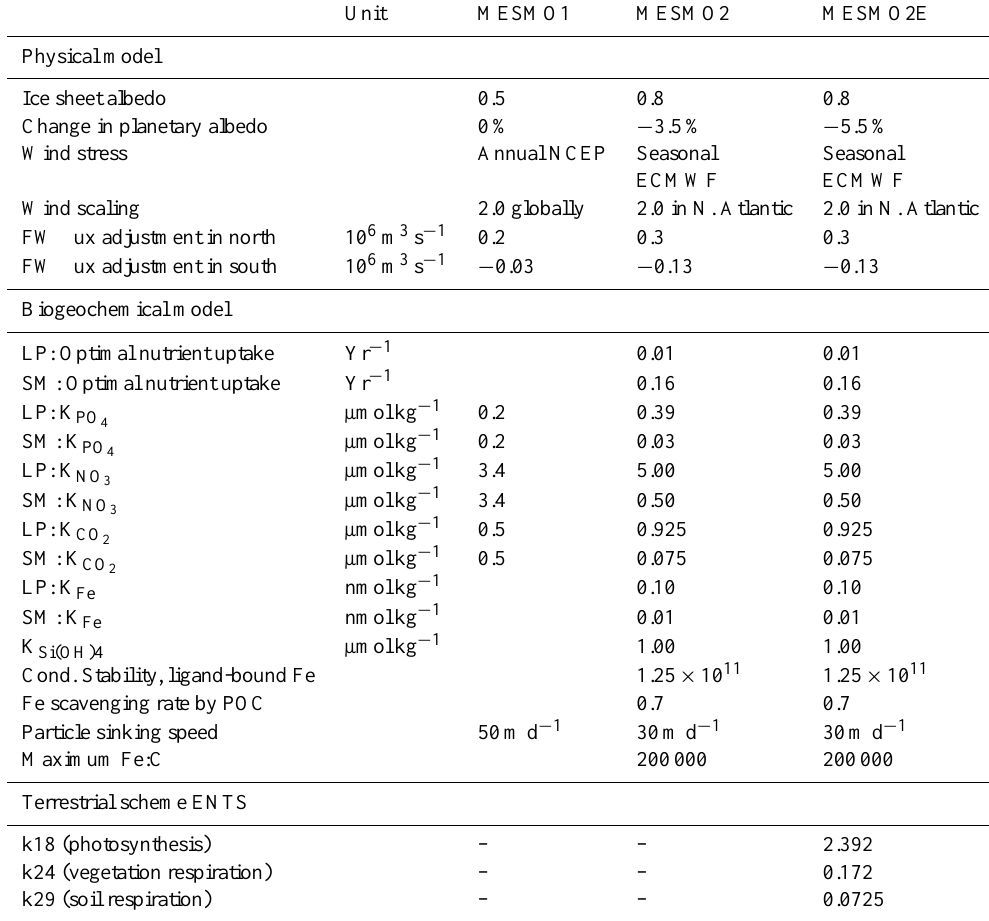
Table 2. Model parameters. In MESMO 1, there is only one class of phytoplankton that carries out export production and, therefore, only one half saturation constant for each limiting nutrient. In MESMO 2/2E, the half saturation constants for the large (LP) and small (SP) phytoplankton are respectively larger and smaller than the equivalent values for MESMO